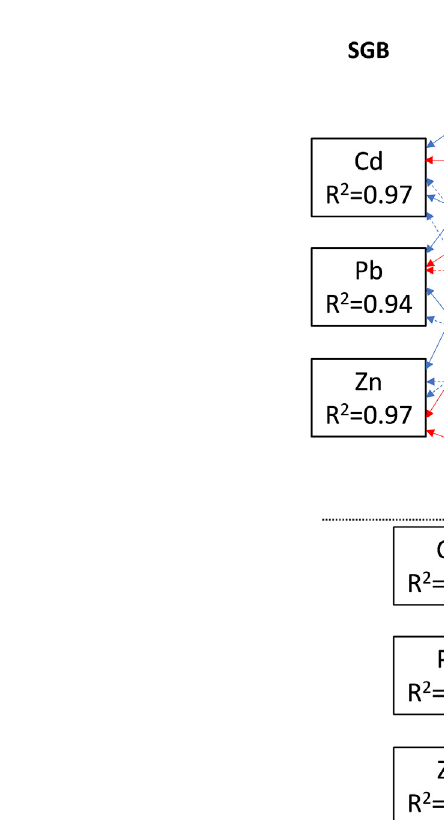
(Figure 4). Those rates correspond to 71.2% ± 1.99% (SGB) and 79.4% ± 5.27% (PLB) of reduced Zn uptake (Figure 4). These results